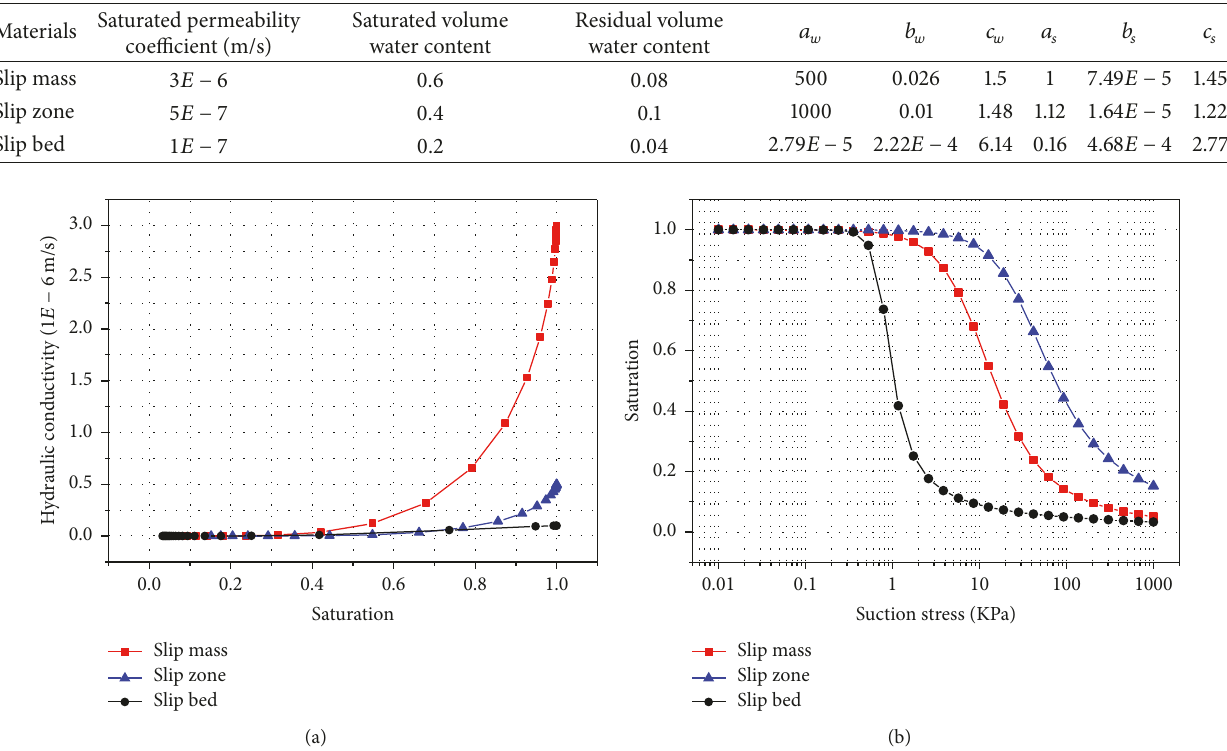
Table 1: Permeability parameters of the Baijiabao landslide model.